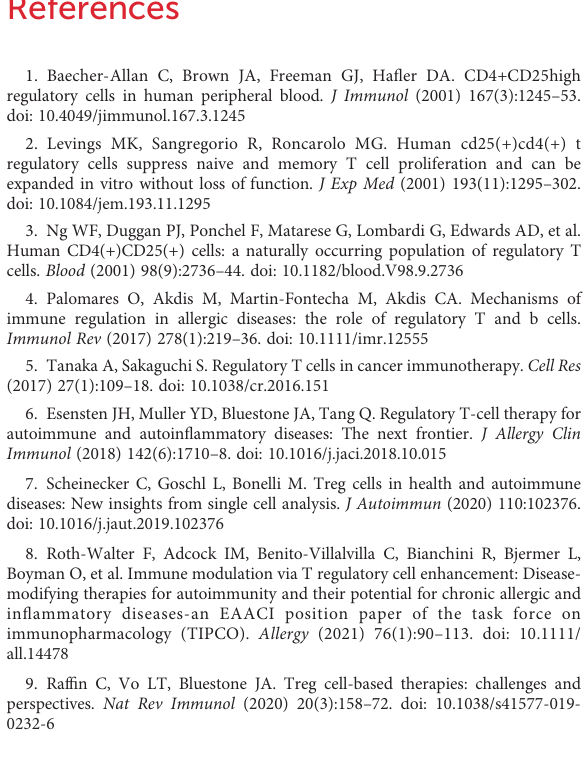
SUPPLEMENTARY FIGURE 1 Identi fi cation of Treg and Tconv cells. A. Representative dot plots for identi fi cation of Treg cellsbased on theexpression of CD25 andFOXP3 or CD25 and CD127. B. Correlation between the frequencies of Treg cell